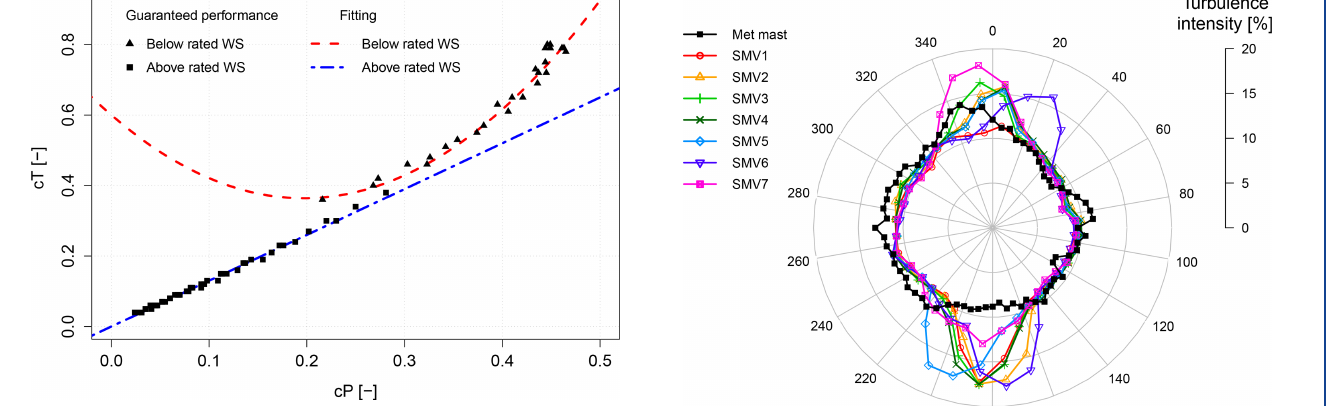
Figure 8. Correlation between c P and c T for a Senvion MM82 wind turbine, deduced from the analysis of guaranteed power curve modes for sound management.